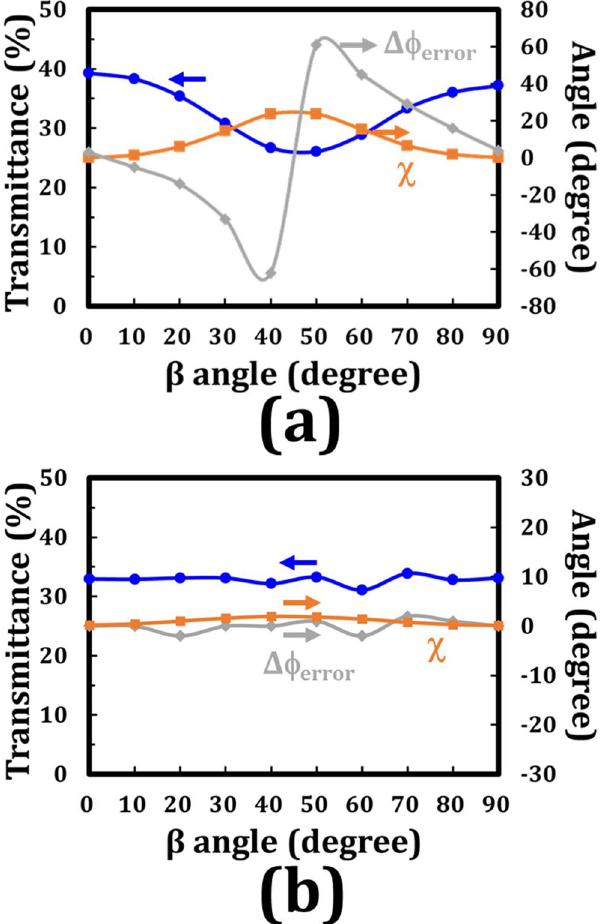
Figure 8. Experimental results of variations in transmittance (blue), χ angle (orange) and Δφ error angle (gray) as functions of the β angle (0°–90°) of ( a ) a conventional 90°-TNLC cell and ( b ) a tandem-90°-TNLC cell, respectively. Transmittance is defined as the transmittance of the output beam through a TNLC cell and an analyzer with its transmissive axis of 90° with respect to that of the polarizer ( β ). The light absorbance by polarizers and the light reflection from the boundaries are